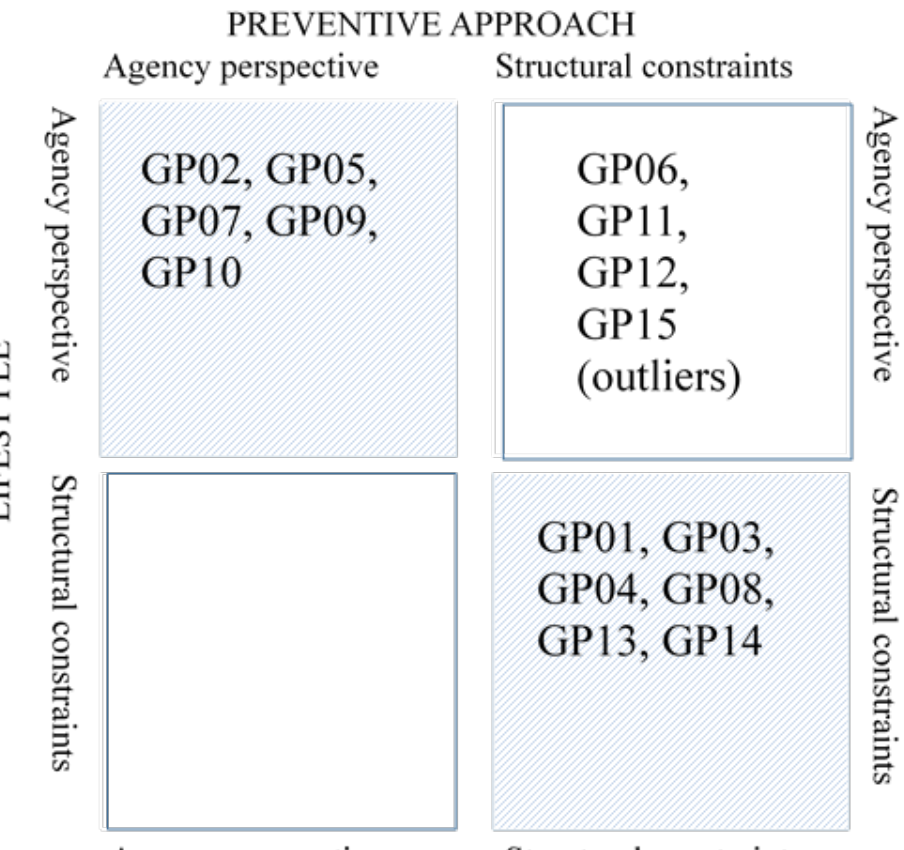
Correspondance between lifestyle preferences and preventive